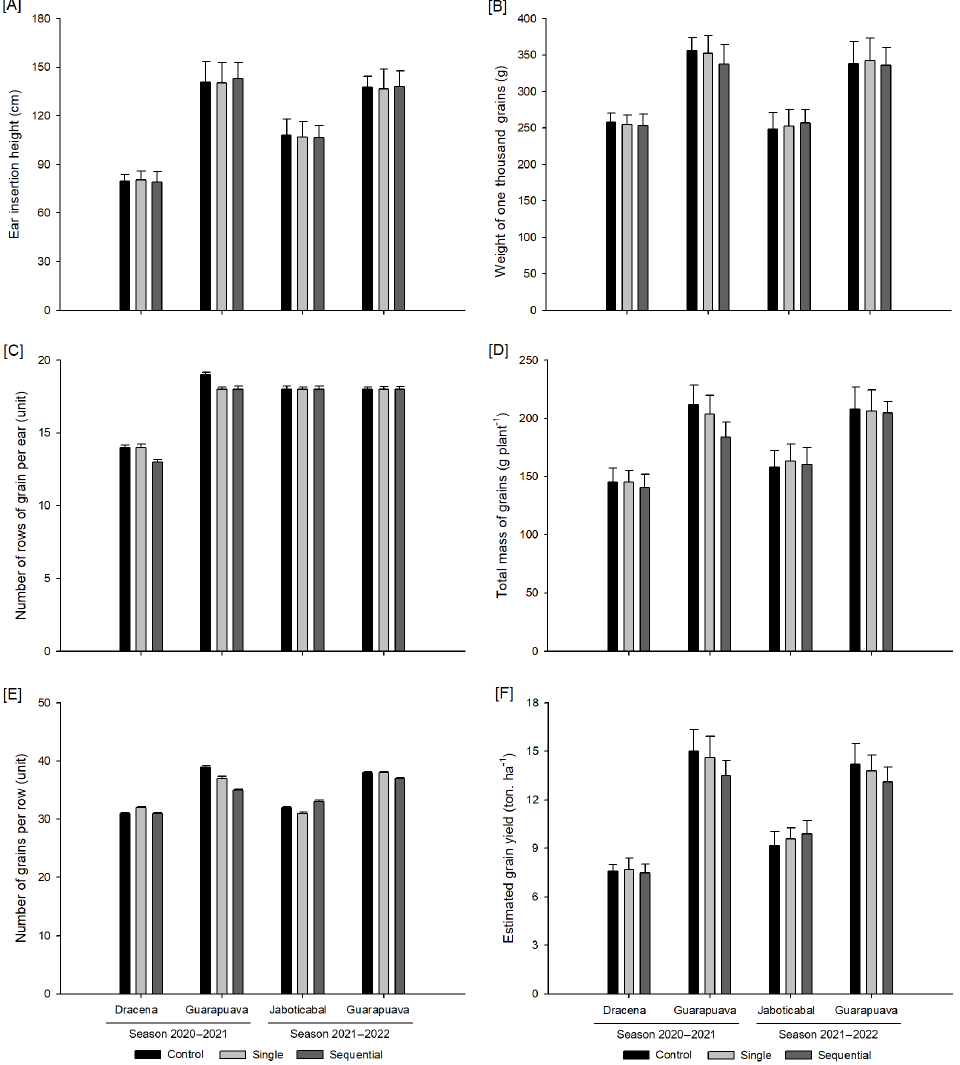
Figure 3. Ear insertion height ( A ), weight of one thousand grains ( B ), number of rows of grain per ear ( C ), the total mass of grains ( D ), number of grains per row ( E ), and the estimated grain yield ( F ) of GR maize grown with no herbicide application (control), with a single application of glyphosate at 980 g of a.e. ha −1 at stage V5 (single) and a sequential application of glyphosate at 520 + 980 g of a.e. ha −1 at stage V3 and stage V7, respectively (sequential), in different locations and seasons. Error bars are one SE of the mean from ten replicates . 8.6% crude protein, 6.8 to 7.9% total lipids, 12.8 to 14.3 g kg −1 for N, 2.02 to 2.22 g kg −1 for P, 3.12 to 4.53 g kg −1 for K, 34.2 to 42.9 g kg −1 for Ca, 0.99 to 1.24 g kg −1 for Mg, 0.90 to 0.98 g kg −1 for S, 2.06 to 2.56 mg kg −1 for Cu, 4.26 to 6.69 mg kg −1 for Fe, 4.06 to 4.82 mg kg −1 for